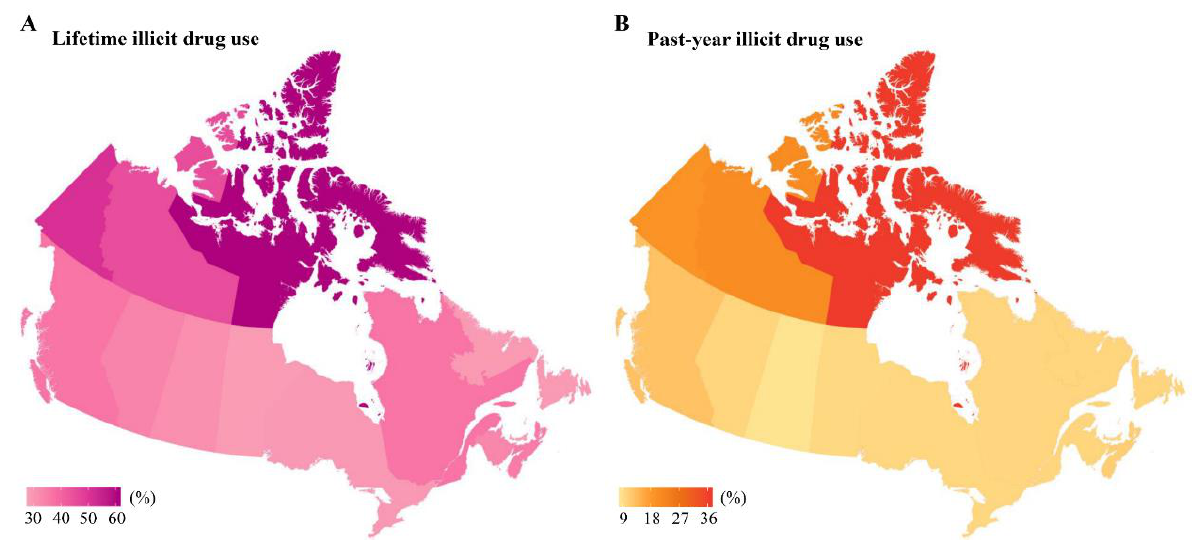
Figure 1. Prevalence of lifetime ( A ), and past-year ( B ) illicit drug use by province/territory in Canada. Table 1. Prevalence of lifetime, and past-year illicit drug use by province/territory in Canada. Geographic Location